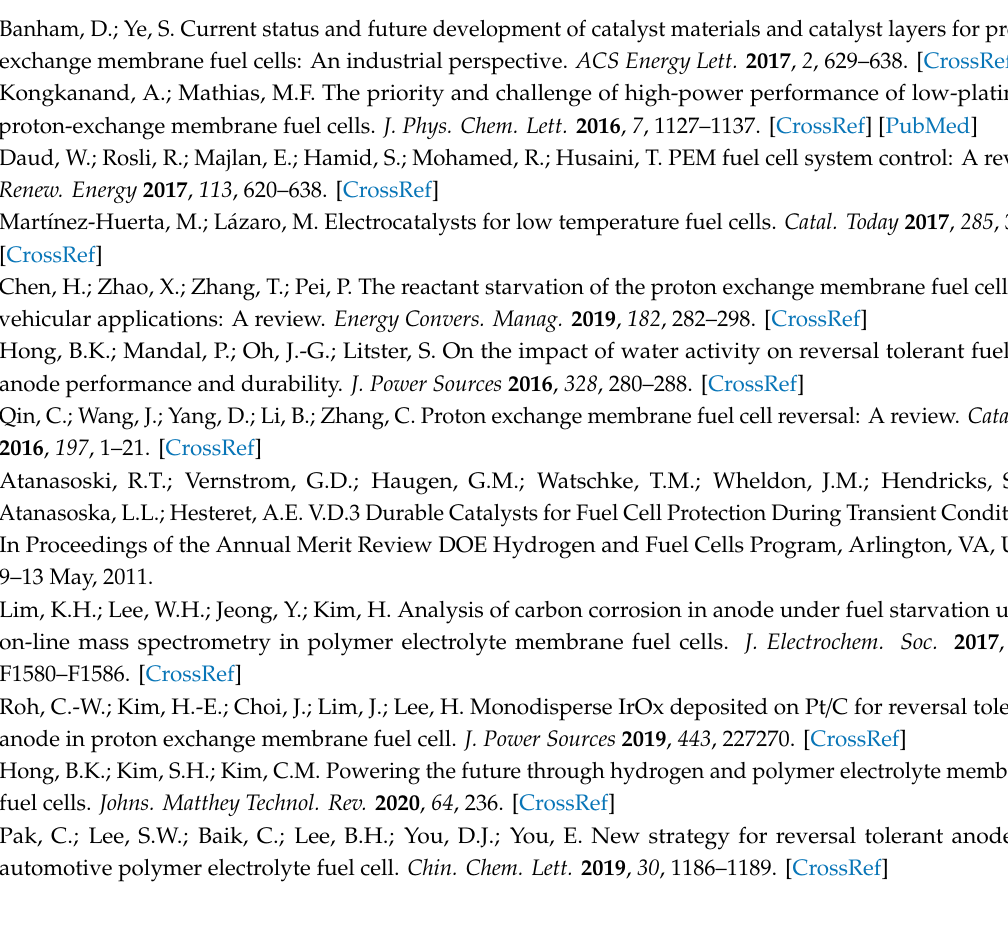
Figure S1: Raman spectra of KB, 10 KB, 22 KB and 28 KB carbon supports, normalized to the same maximum peak height, Figure S2: Voltage–time (V–t) plot of 22 KB, Ru / 22 KB, Ir / 22 KB and Pt / 22 KB anode MEAs, Table S1: N 2 adsorption BET surface areas and Raman spectroscopic parameters of the carbon black